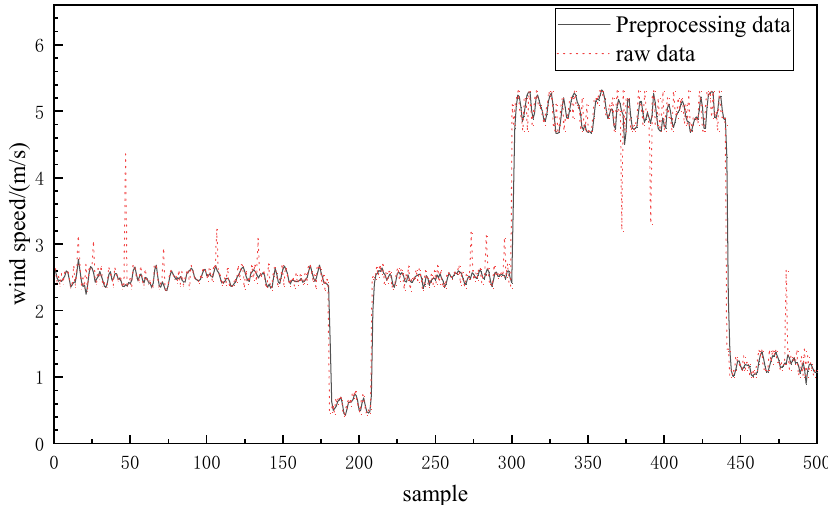
Figure 3. Outliers Detection and Processing Results. Table 2. Risk table of monitoring